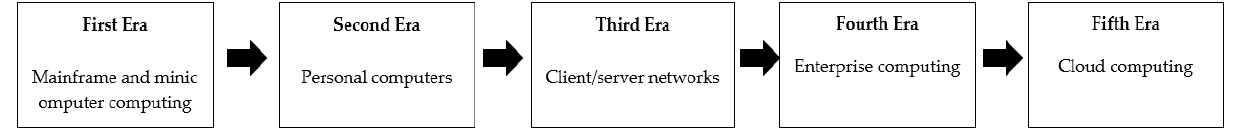
Figure 1. Timeline of information management.